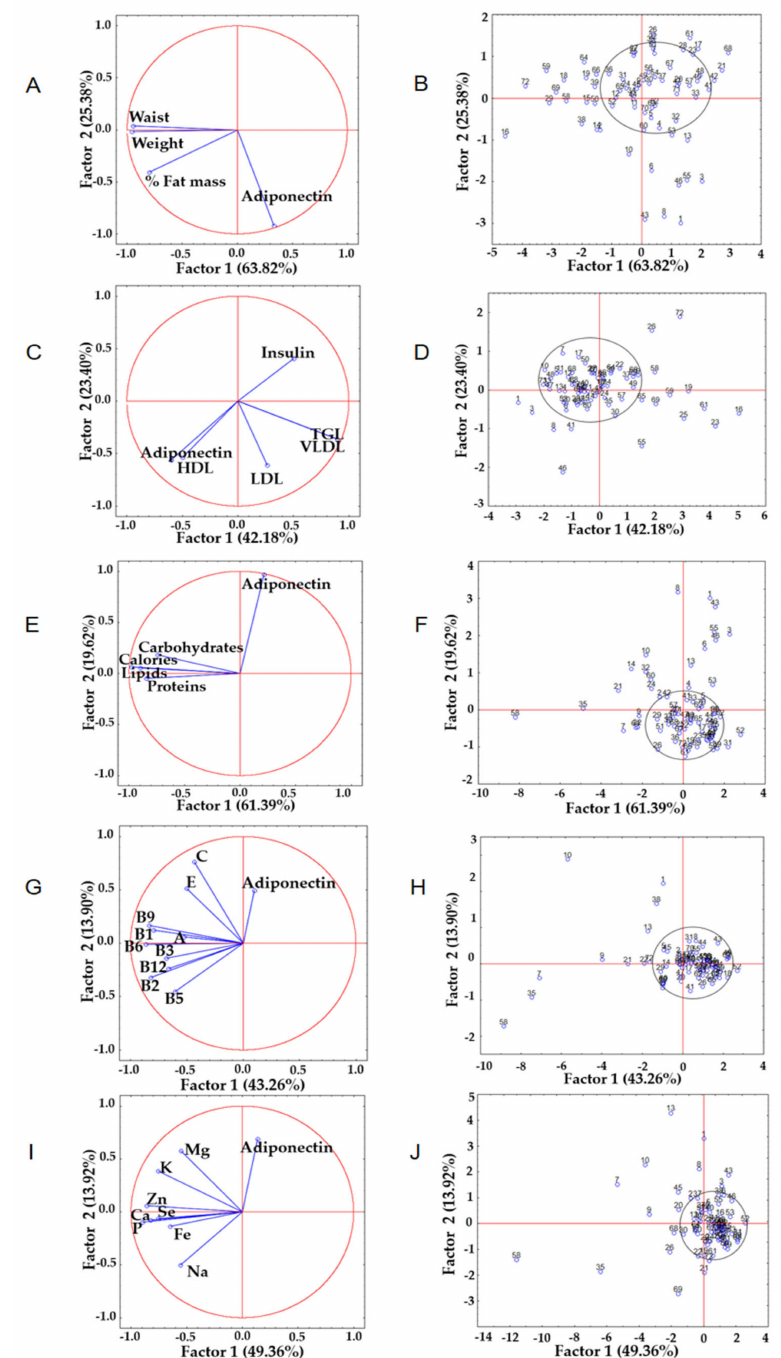
Figure 3. Principal component analysis (PCA). Left column: relationship between adiponectin and anthropometric parameters ( A ), biochemical parameters ( C ), caloric and macronutrient intake ( E ), vitamin intake ( G ), and mineral intake ( I ). Right column: distribution of pattern similarities among the studied subjects: anthropometric parameters ( B ), biochemical parameters ( D ), caloric and macronutrient intake ( F ), vitamin intake ( H ), and mineral intake ( J